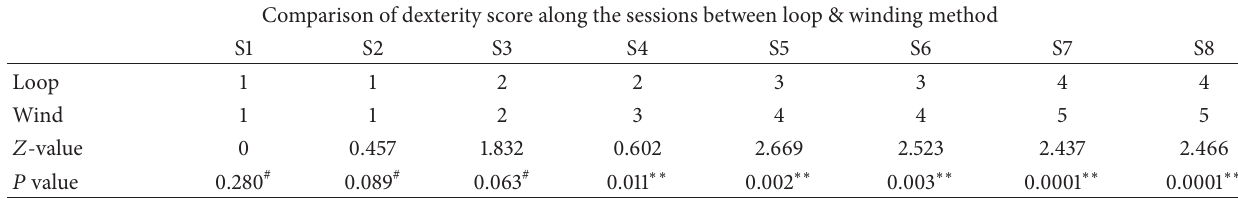
Table 5: Comparison of dexterity (1–5) in the end of session was done between groups A and B. Comparison of dexterity score along the sessions between loop & winding method S1